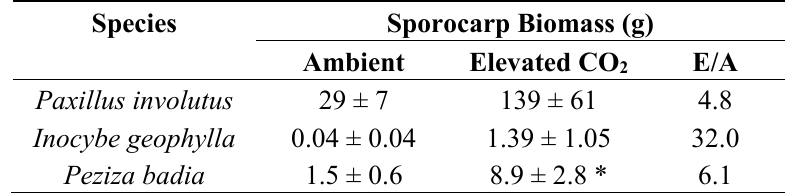
Table 1. Total sporocarp biomass of fungi collected for ambient treatment and elevated CO 2 plots at BangorFACE in